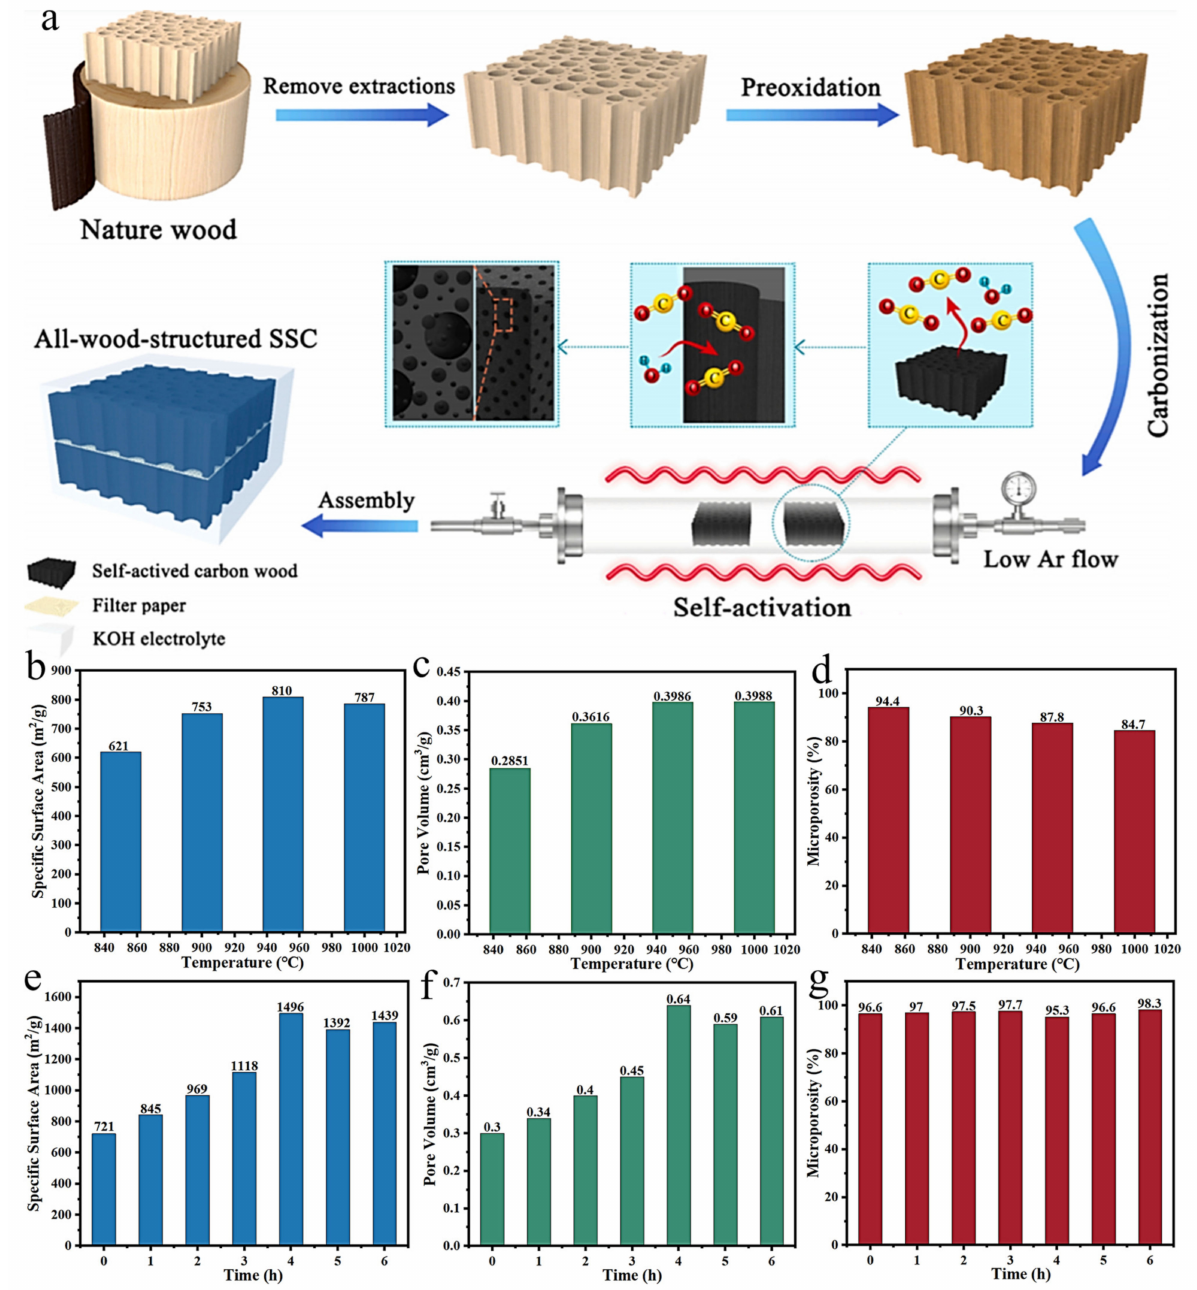
Figure 8. ( a ) Schematic diagram of preparing wood-derived carbon materials by self-activation [95]; ( b – d ) Impact of temperature on physical activation effect [89]; ( e – g ) Impact of char/alkali mass ratio on NaHCO 3 activation effect